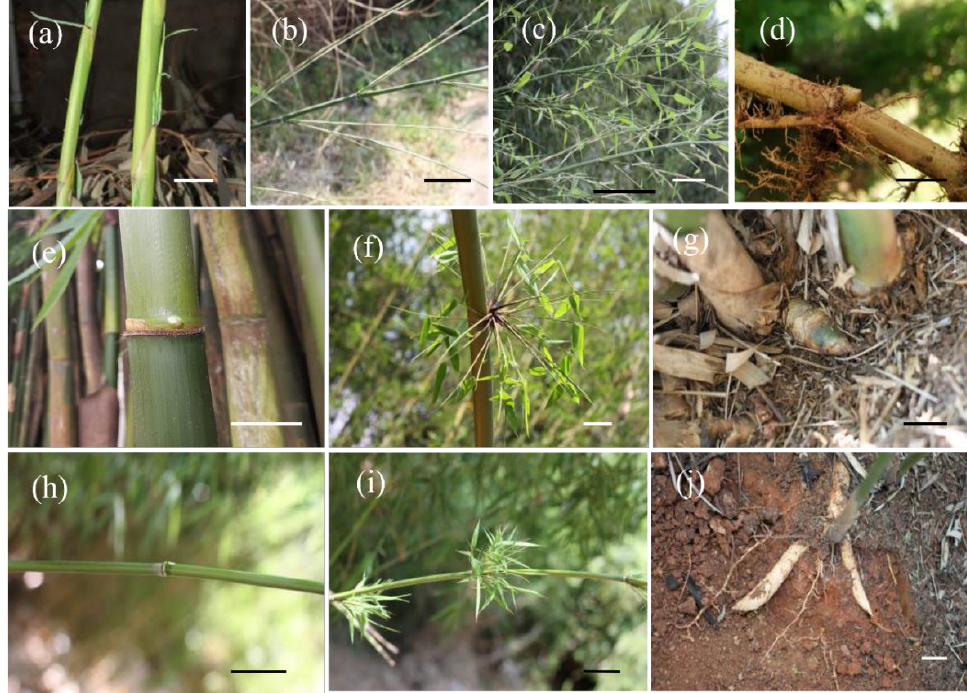
Figure 2. Different phenological phenomena of the three bamboo types. ( a ) Nodal buds of new Ph. mannii culms started sprouting in early April, while culm sheaths did not fall off and their internodes did not complete the elongation growth. Bar = 2 cm. ( b ) Branch extension was observed new Ph. mannii culms in late April. Bar = 8 cm. ( c ) New leaves appeared on the new branches of Ph. mannii in May. Bar = 8 cm. ( d ) New shoot buds started differentiating at the rhizome node underground in July. Bar = 4 cm. ( e ) Nodal buds of 1-year N. affinis culms started sprouting in March. Bar = 5 cm. ( f ) New leaves extended concurrently with branch extension in N. affinis in May. Bar = 8 cm. ( g ) Shoot buds appeared, differentiating and developing at the bases of 1- and 2-year N. affinis culms in May. Bar = 5 cm. ( h ) Nodal buds of 1-year F. yuanjiangensis culm started sprouting in March. Bar = 3 cm. ( i ) New F. yuanjiangensis culms extended branches and leaves simultaneously in March. Bar = 3 cm. ( j ) Shoot buds of F. yuanjiangensis culms started differentiating to form a pseudorhizome in March. Bar = 2 cm.